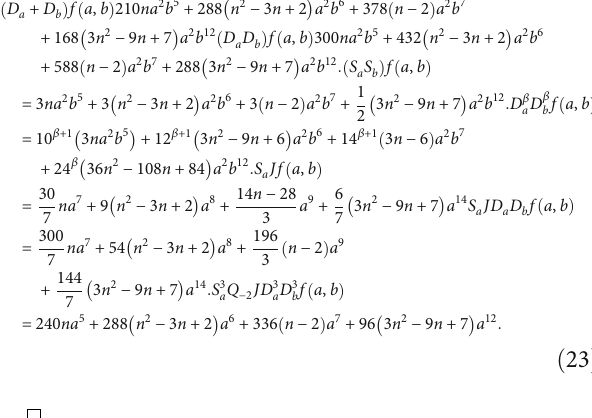
n Þ using 2D 3 ð